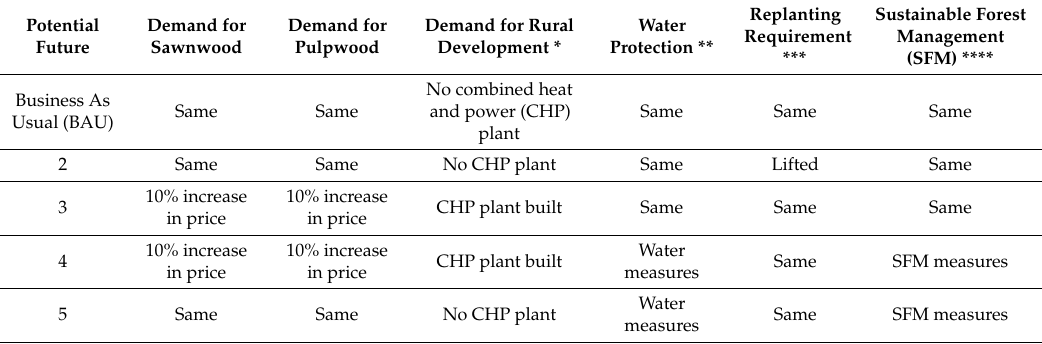
Same No CHP plant